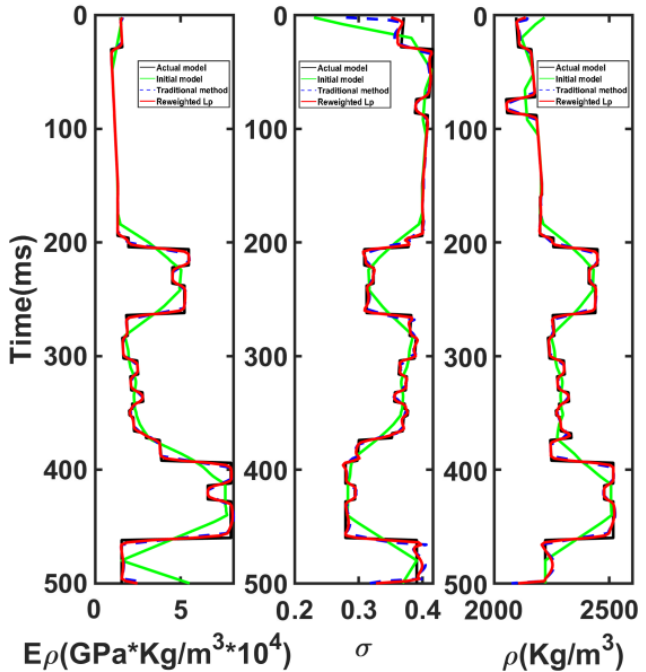
Figure 10. Comparison of inversion results for the 150th trace.